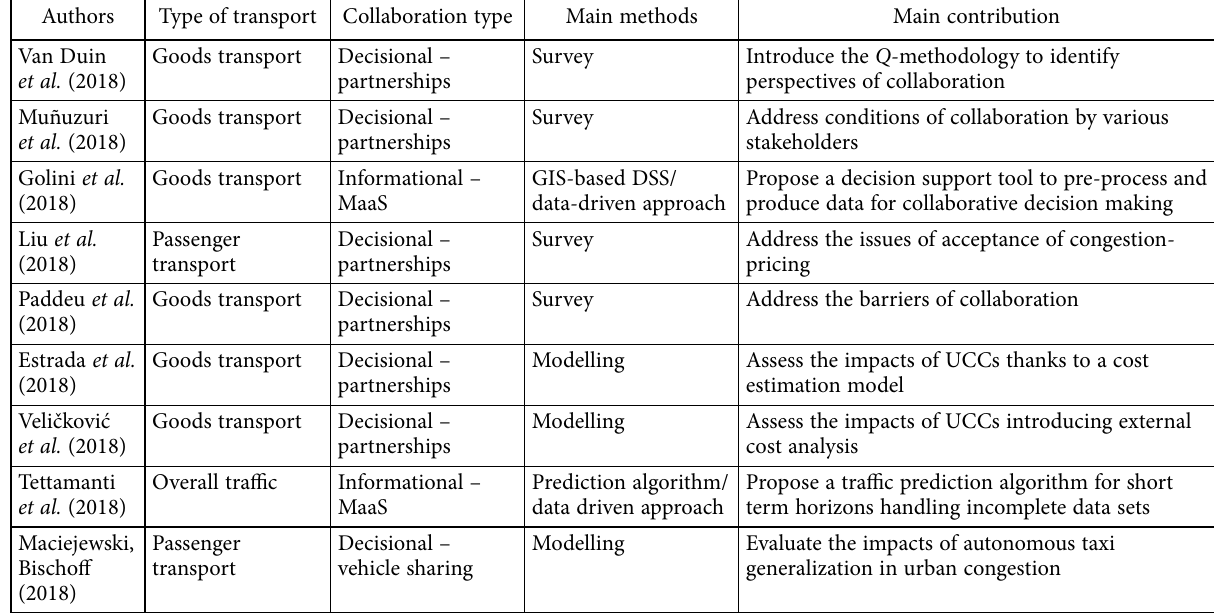
Table 3. Summary of the main topics and contributions of the set of papers, selected from the Special Issue on Collaboration and Urban Transport , which deal with the field of multi-stakeholder and collaboration in urban